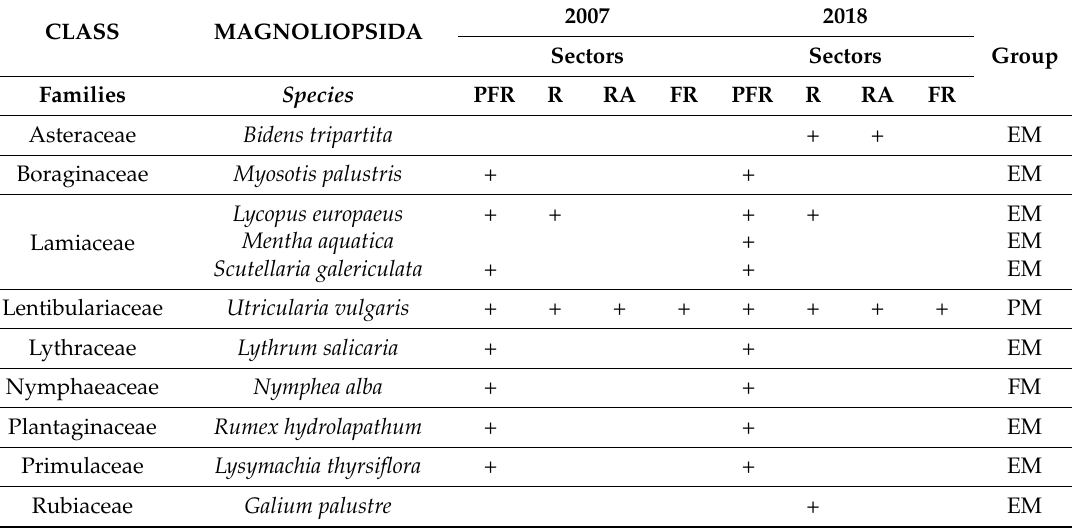
Table 7. The species composition of macrophytes of the littoral of Lake Piaseczno in 2007 and 2018 (EM, emerging macrophytes; SM, submerged macrophytes; FM, floating macrophytes; PM, pleuston